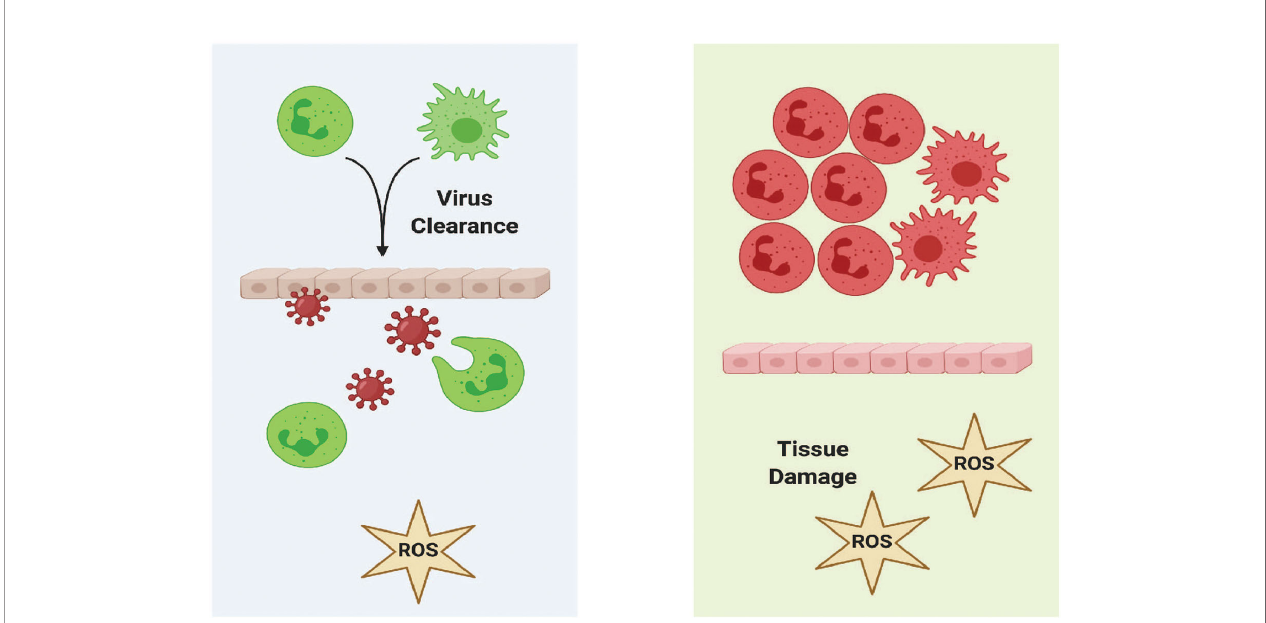
FIGURE 4 | Immunological Tipping Point in The In fl ammatory Response to Virus Infection. A balance between the role of antiviral and hyperin fl ammatory responses by neutrophils must be maintained to avoid tissue damage during infection by IAV or other viruses. We hypothesize that the modulation of ROS is a central factor in regulating the response to virus